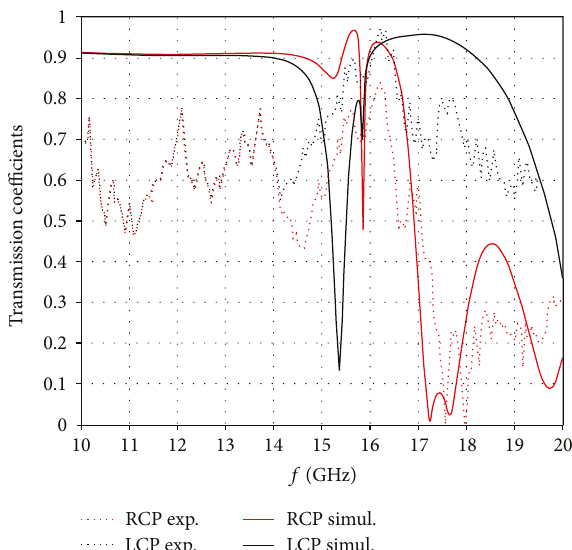
Figure 5: Variation of the simulated and measured RCP and LCP transmission coe ffi cients over the frequency band 10 – 20 GHz.